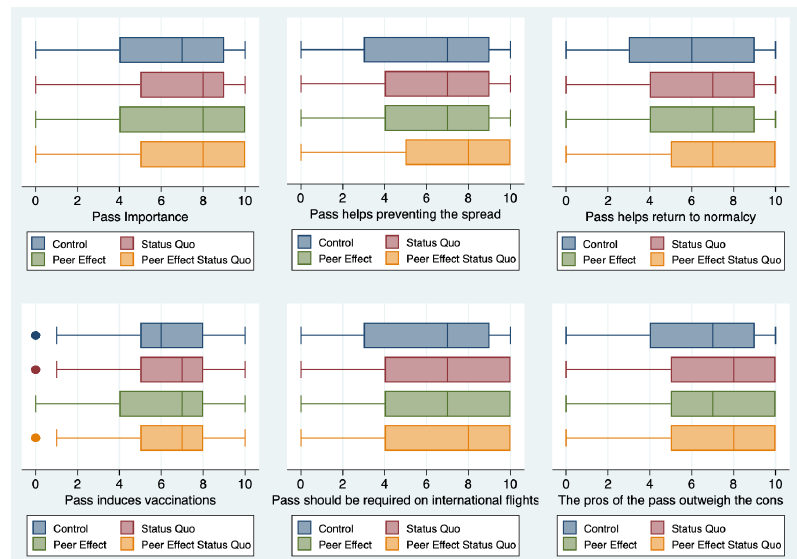
Figure 4. Summary of results for the statements meant to capture positive attributes of the COVID pass (statements 1–3, 10, 11, and 13). The boxplots show the distribution of responses in the Control, Status Quo, Peer Effect, and Peer Effect + Status Quo groups without any additional control. A higher value corresponds to more favorable attitudes towards the pass.